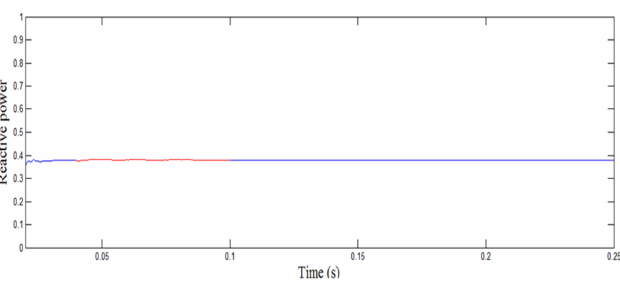
Figure 25. Reactive power demand from the load